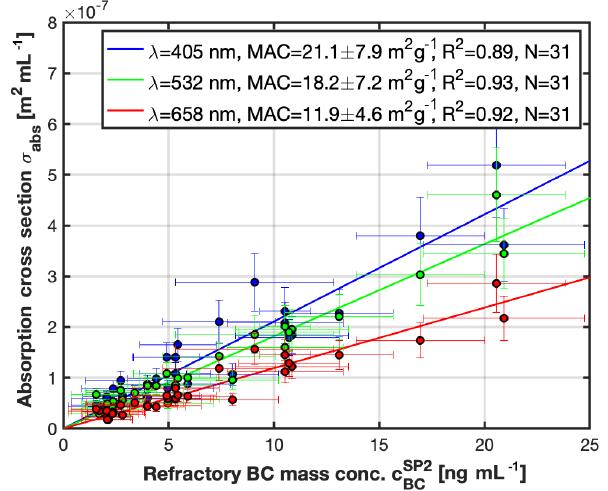
Figure 8. Equivalent BC mass concentration c equiv , Eq. (2), of the BC snow samples as a function of the refractory BC mass concentra- tion c SP2 . The dashed black line represents the 1 : 1 line. Linear re- BC BC gression without intercept per wavelength gives the mass “enhance- ment” factor λ , which is given in the legend. The white diamond symbol marks the 532nm values of the 10 March snow sample that was further analysed for elemental composition, particle morphol- ogy, and fluorescence response. See text for